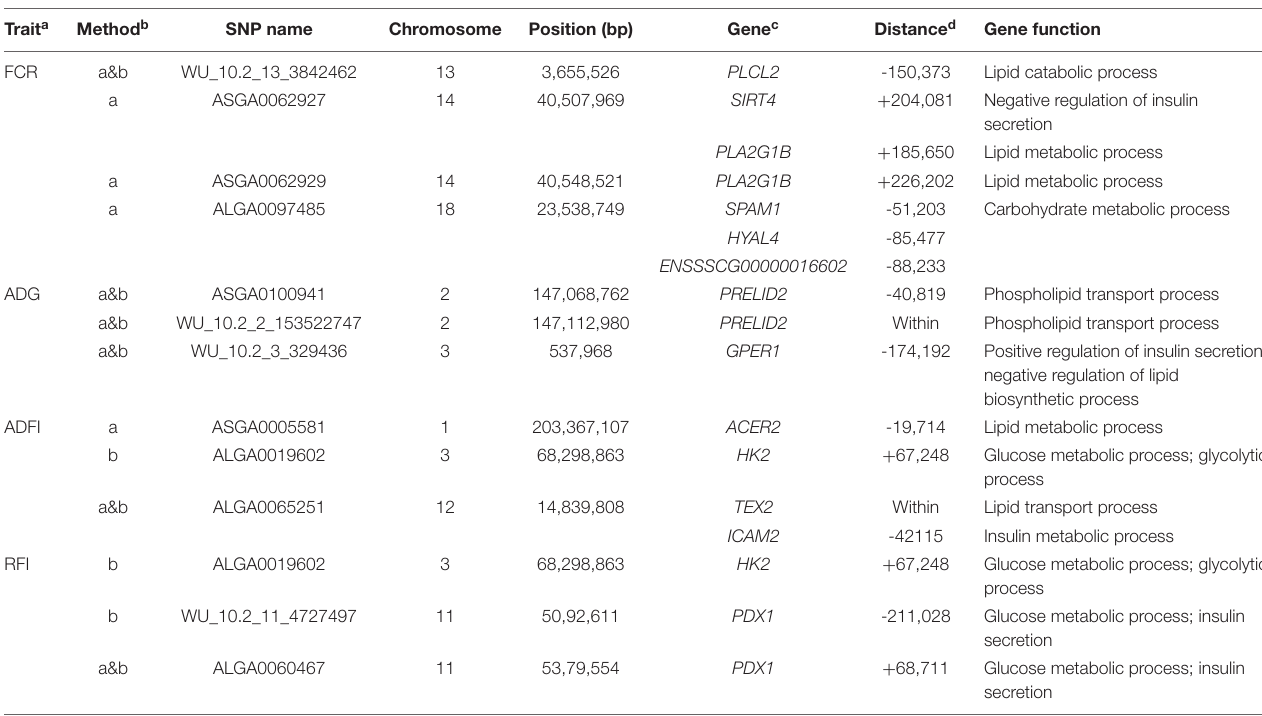
TABLE 3 | Significant SNPs and related genes for four feed efficiency